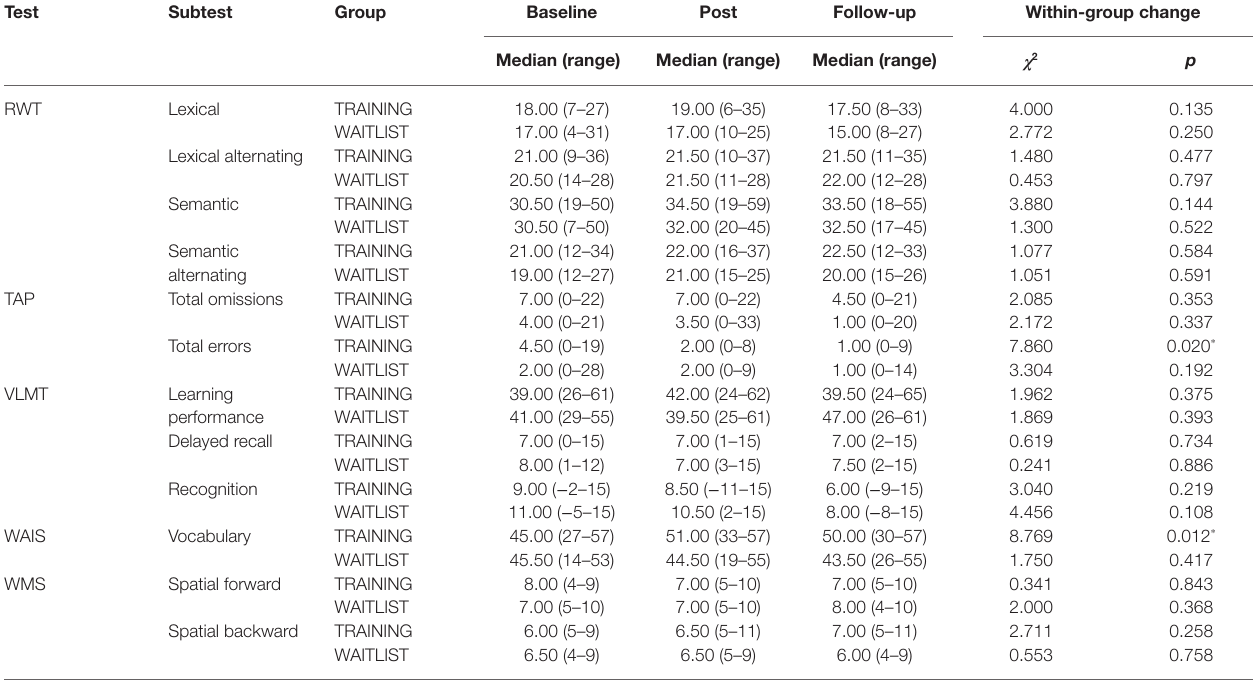
TABLE 6 | Neuropsychological test performance for all measurement points.